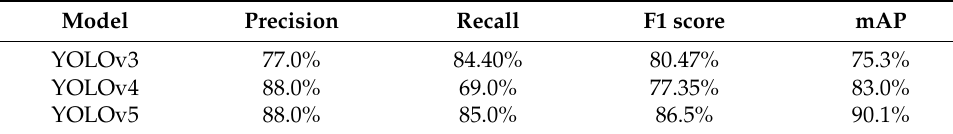
Figure 6. Confusion matrix of YOLOv5 model on test dataset. Table 2. Evaluation indicators of the models.